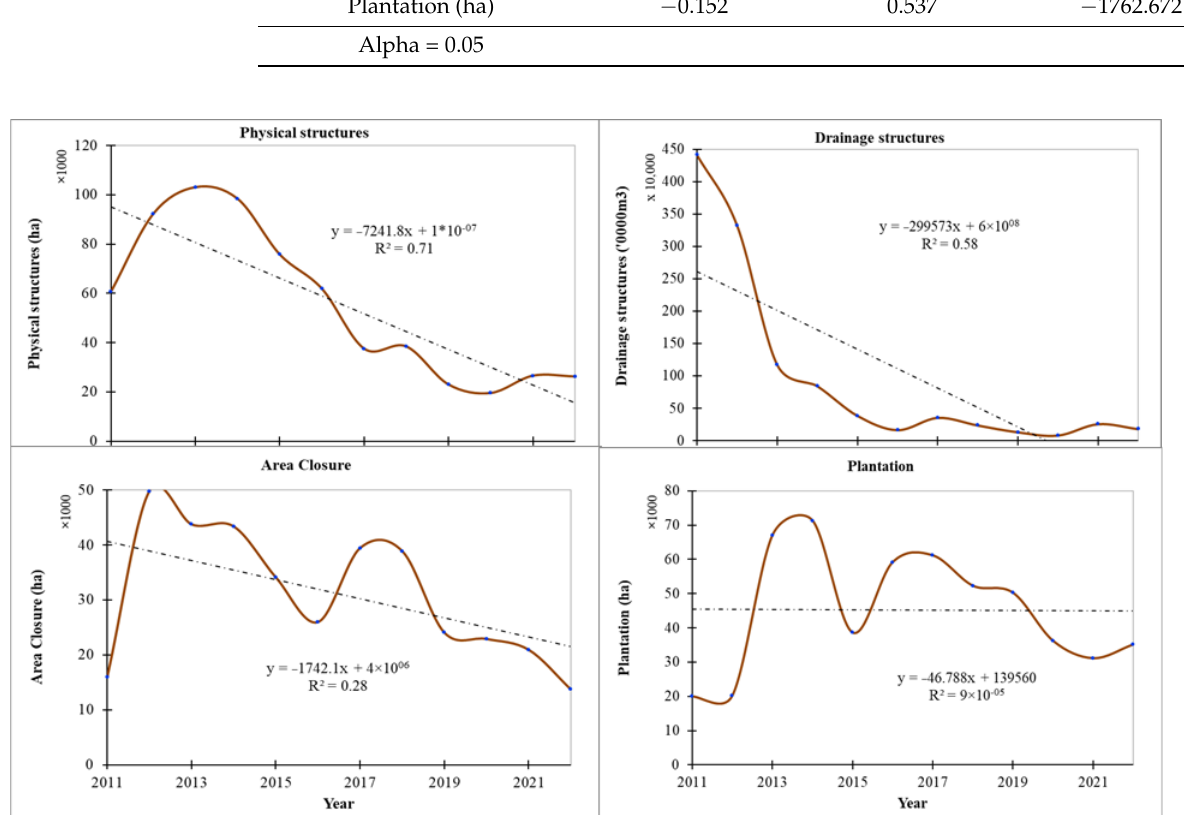
Figure 5. Trends of biophysical conservation measures over twelve years using the Mann–Kendall trend test graph and the regression. The dot lines are trend lines or lines of best fit indicating the general direction of points.